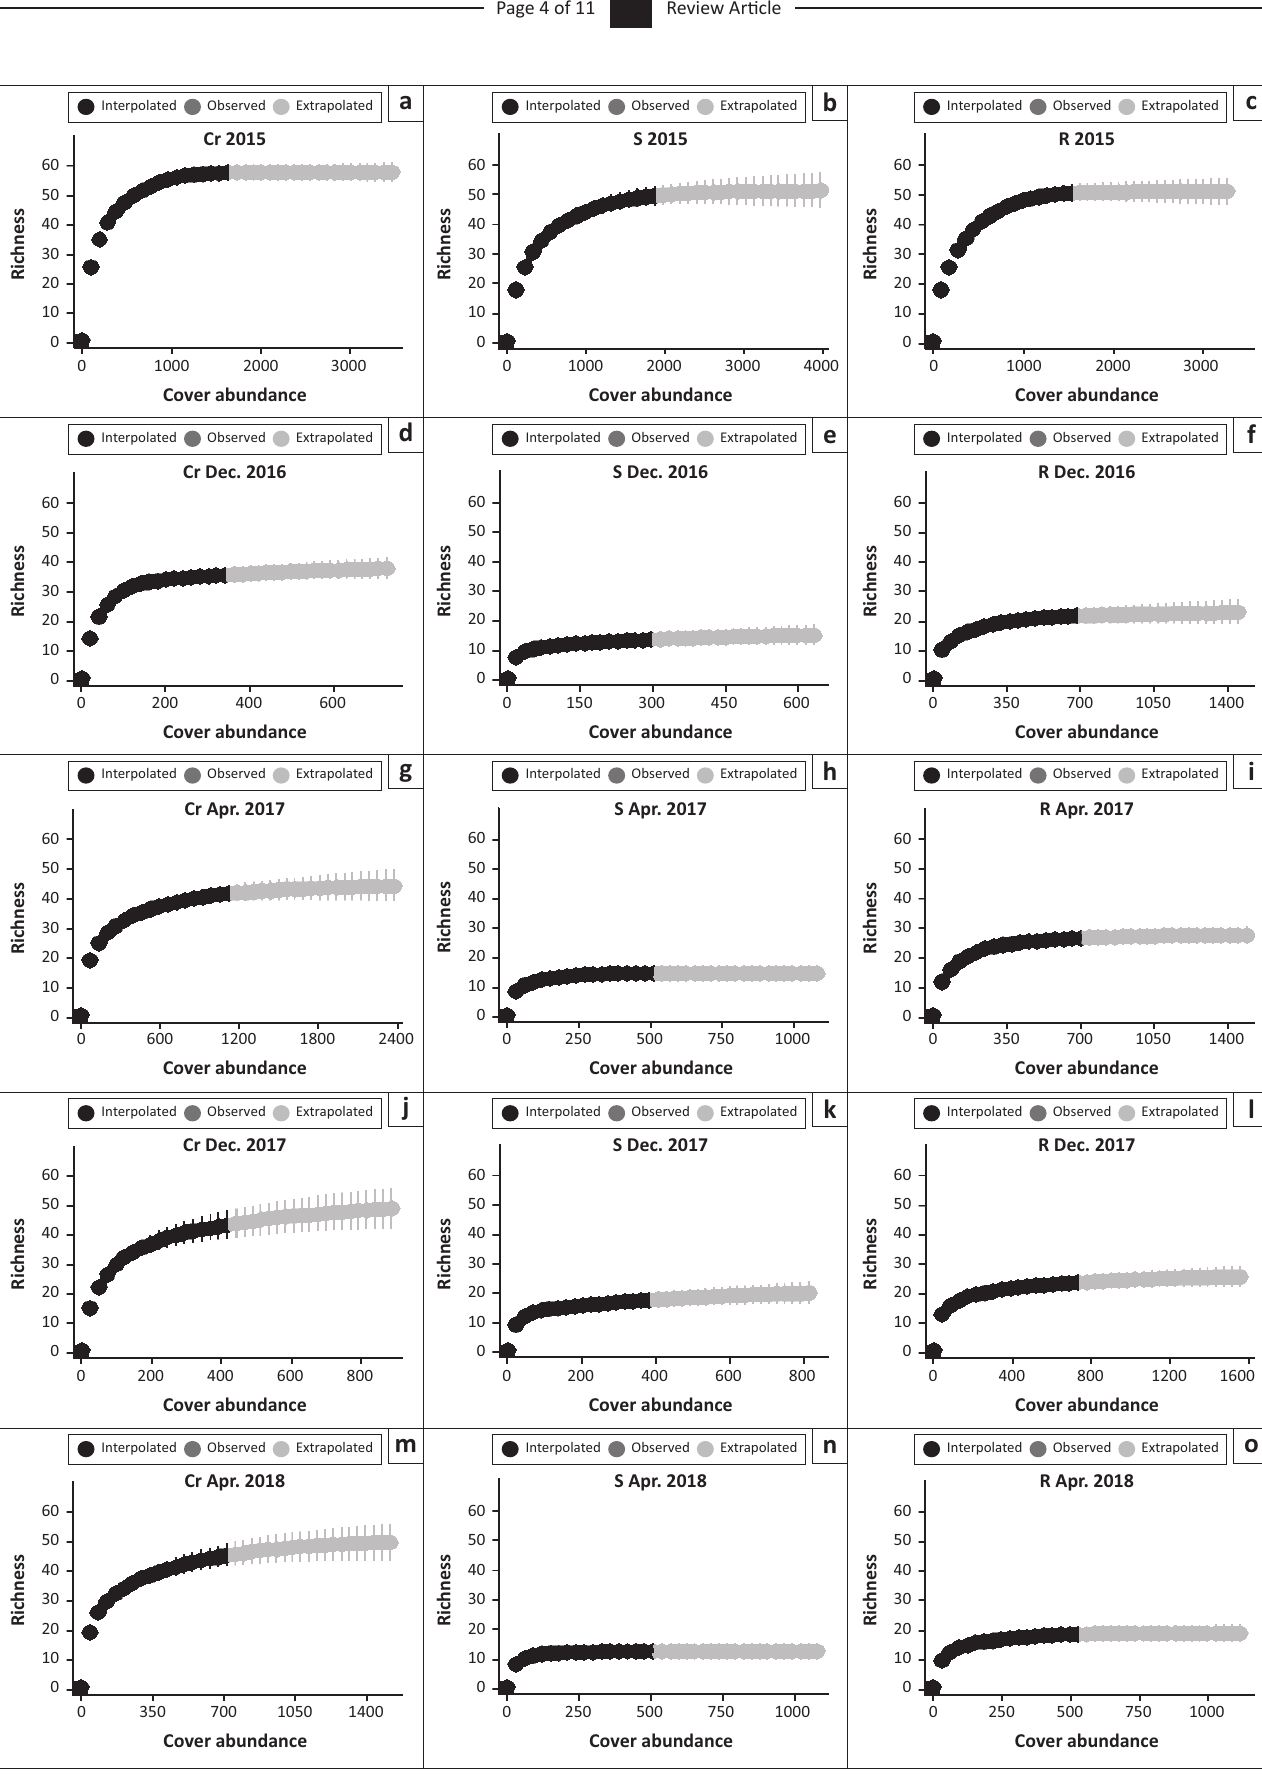
FIGURE 2: Rarefied species accumulation curves for herbaceous vegetation from the three habitats (Cr = crest, S = sodic, R = riparian) sampled at five time intervals from a single catenal transect (10 m 2 neighbouring relevés forming 500 m long belt transect) in the southern KNP. Error bars depict 95 % confidence intervals of the richness